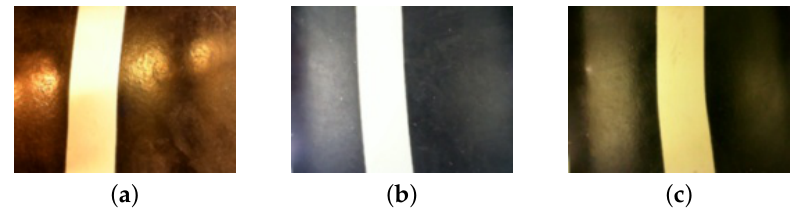
Figure 16. Comparison among the images on different camera settings. ( a ) no forced lighting box and camera default settings; ( b ) AGV with the forced lighting box and camera default settings; ( c ) AGV with the forced lighting box and camera custom